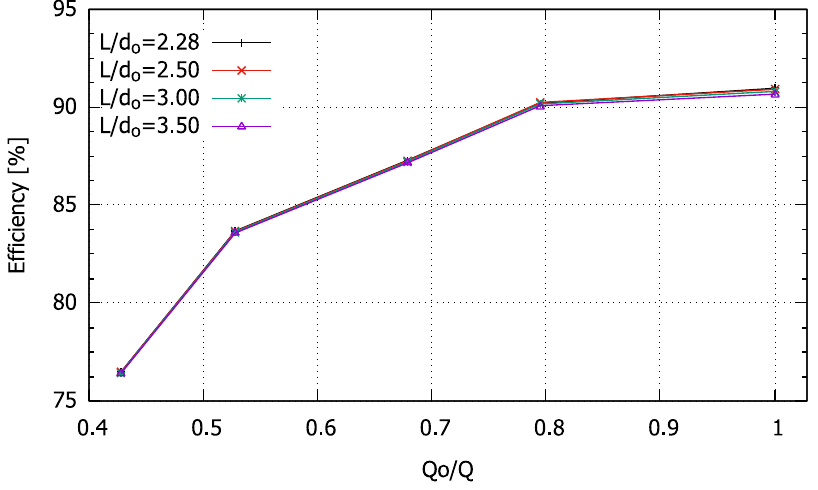
Figure 15. Influence of L parameter.